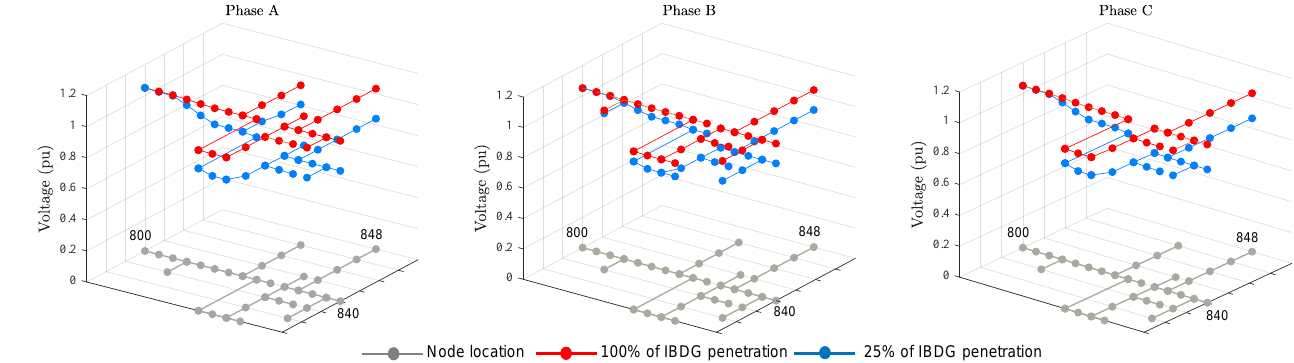
Figure 8. Voltage profiles with 25% and 100% of κ A using the proposed